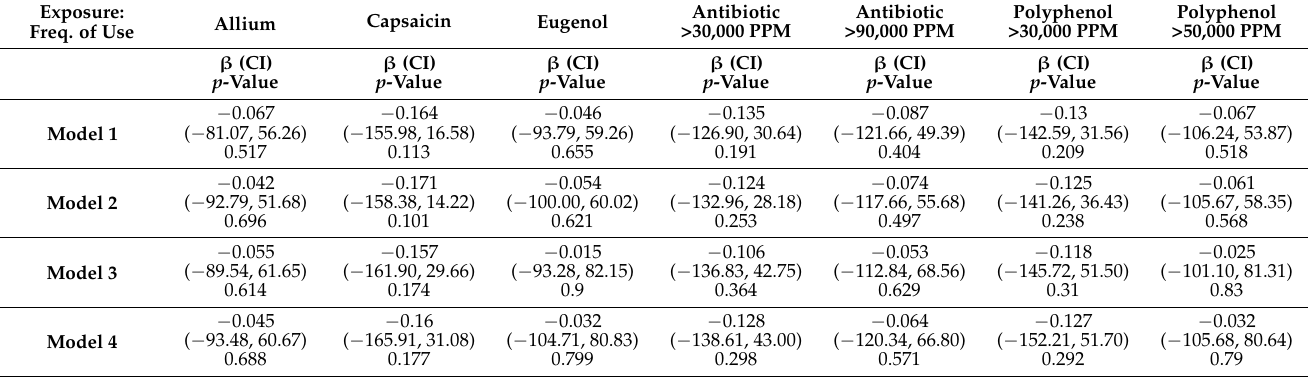
Table 6. Association between frequency of culinary herb use and Bacteroidota abundance.